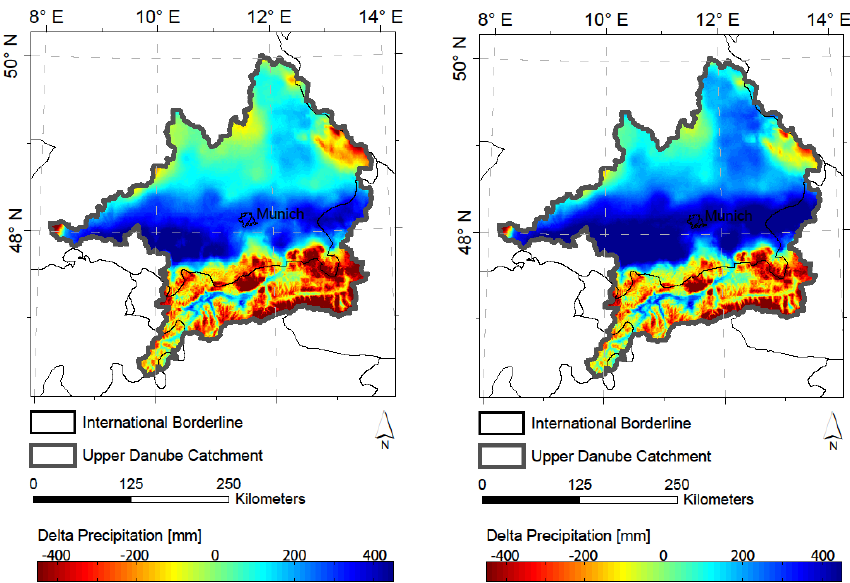
Figure 9: Over- and underestimation of annual simulated 2-way coupled PROMET/MM5 (left) Fig. 9. Over- and underestimation of annual simulated 2-way coupled PROMET/MM5 (left panel) and NOAH/MM5 (right panel) precipita- and NOAH/MM5 (right) precipitation in the Upper Danube catchment, downscaled to 1 km by tion in the Upper Danube catchment, downscaled to 1km by using SCALMET and subtracted from measurements. using SCALMET and subtracted from measurements.